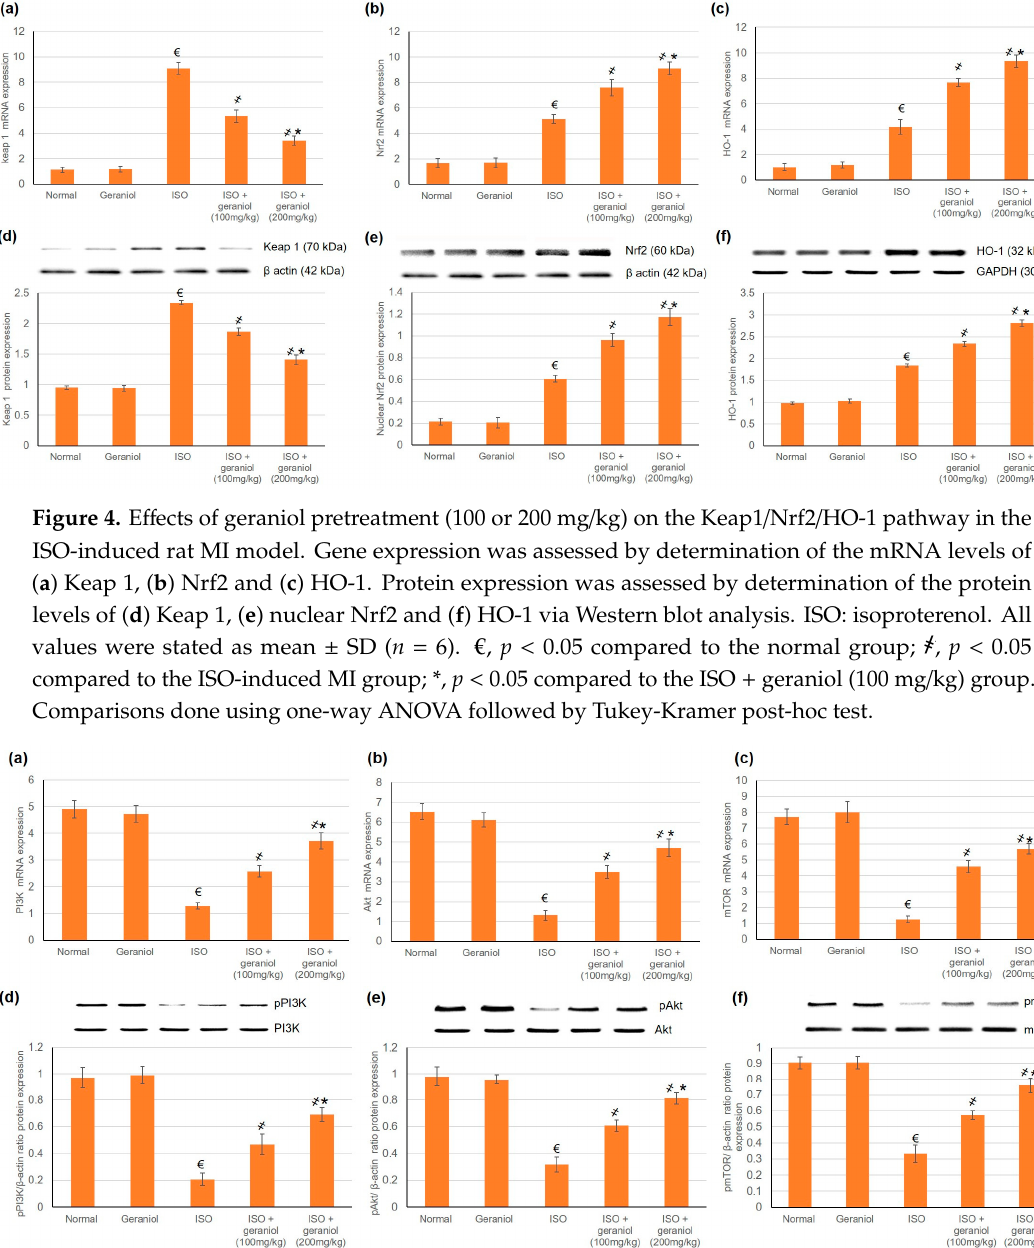
Figure 5. Geraniol (100 or 200 mg / kg) increased the gene and protein expression levels of the PI3k / Akt / mTOR pathway in myocardial infraction rat models. The mRNA expression levels of ( a ) PI3K, ( b ) Akt, and ( c ) mTOR, and the protein expression levels of ( d ) phosphorylated PI3K (pPI3k), ( e ) phosphorylated Akt (pAkt), and ( f ) phosphorylated mTOR (pmTOR) were increased in response to geraniol pretreatment. ISO: isoproterenol. All values were stated as mean ± SD ( n = 6). € , p < 0.05 compared to the normal